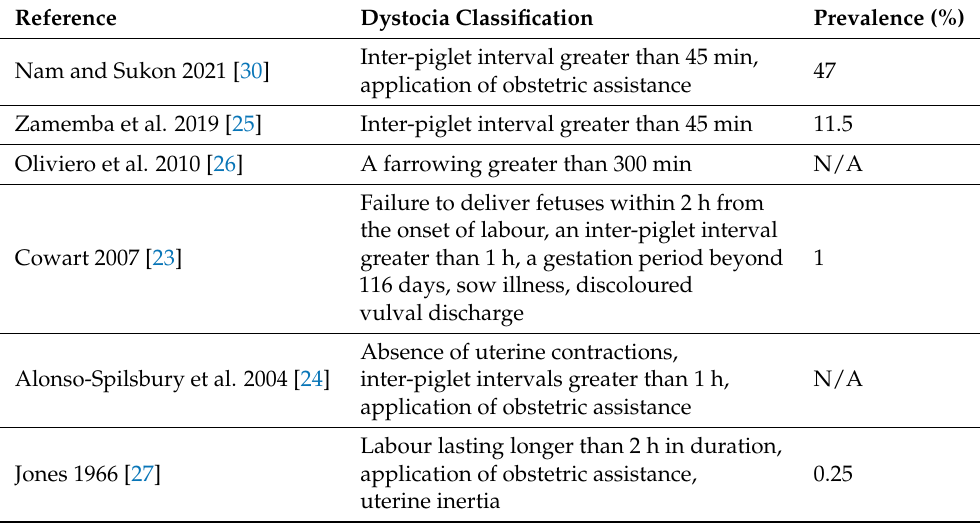
Table 1. Proposed definitions and cited prevalence of dystocia in the pig by previous